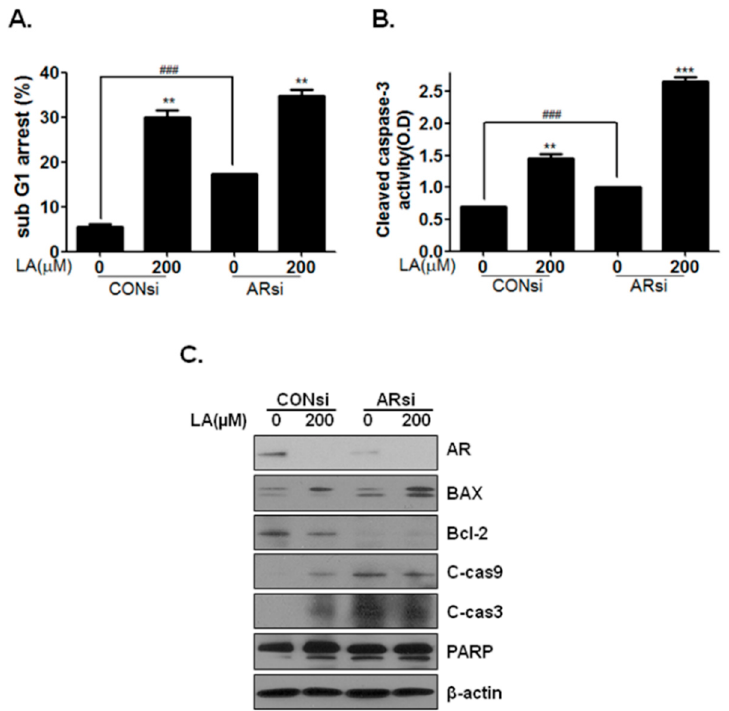
Figure 5. Effect of silencing androgen receptor (AR)-induced apoptosis of LNCaP cells. ( A ) Cell cycle analysis was measured following treatment with LA (0 and 200 µ M) for 48 h after transfection with AR-siRNA for 24 h in LNCaP cells. ### p < 0.001 and ** p < 0.01 (in comparison to the control); ( B ) Cleaved caspase-3 activity also was measured with treated LA (0 and 200 µ M) for 48 h after transfection with AR-siRNA for 24 h in LNCaP cells; ( C ) LNCaP cells were transfected with AR-siRNA for 24 h, treated with LA (0 and 200 µ M) for 48 h and then subjected to Western blot analysis of apoptosis-related protein expression. ### p < 0.001, ** p < 0.01 and *** p < 0.001 (in comparison to the control).